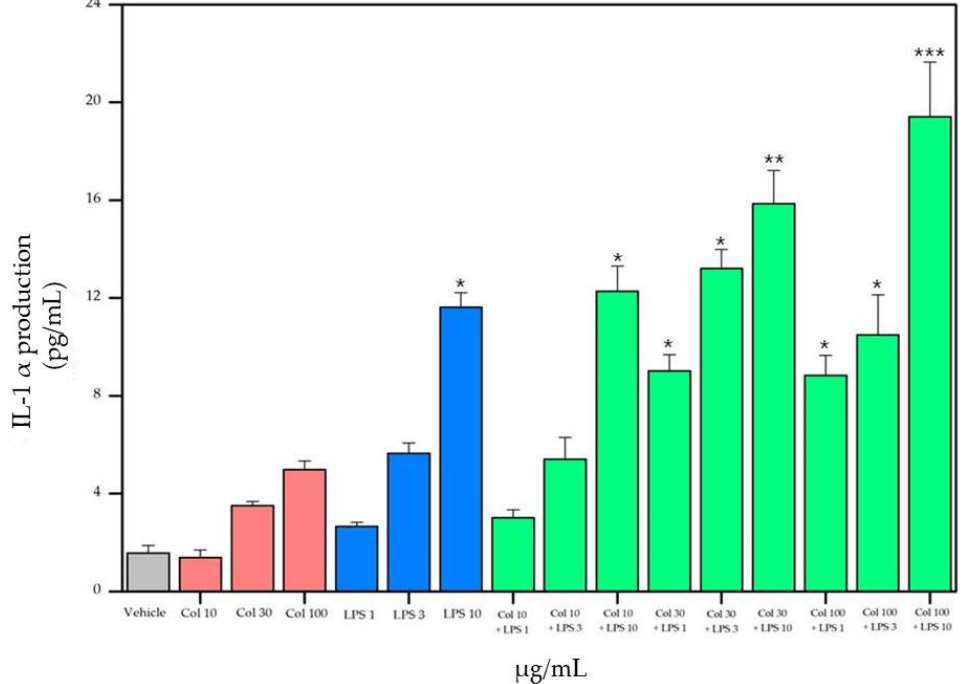
Figure 9. Effect of collagen peptide and LPS on interleukin-1 α production in the supernatant media without RAW 264.7 cells for 48 h. The values are presented as a mean ± standard deviation. The changes were significantly different between the vehicle and test samples, with p < 0.05 (*), p < 0.01 (**), and p < 0.001 (***).